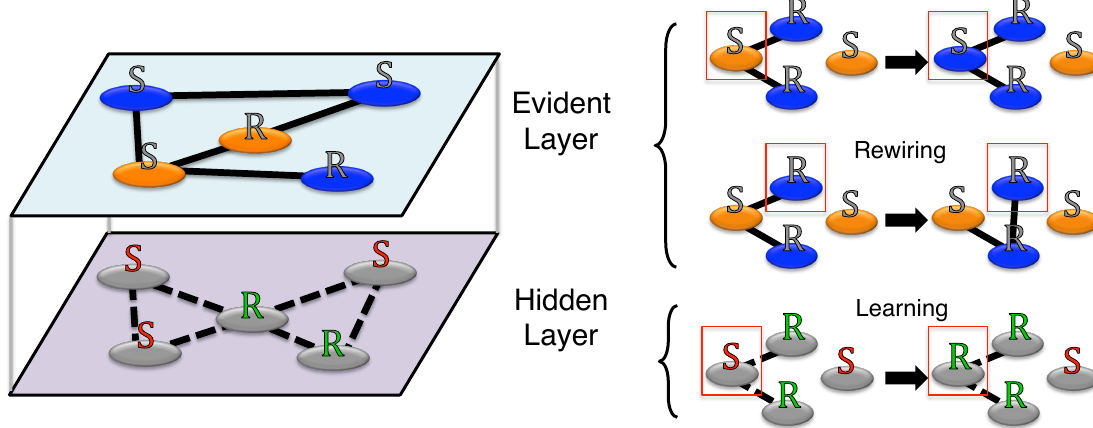
Figure 1. Visualization of the adaptive multiplex network model. The coordination with neighbor actions dynamics happens in the evident layer through imitation (according to S -agents) and rewiring (for R -agents), while the learning dynamics occurs in the hidden layer through payoff-driven strategy imitation. Actions are represented as node colors (orange and blue) while strategies are represented as node labels ( R for rewiring agents, S for staying ones). Imitation refers to the coordination game according to which agents update their actions on the evident layer. Rewiring indicates the possibility, on the evident layer, for an agent to cut a link with a neighbor of opposite action and then create a link with another randomly chosen agent. Learning denotes the propagation of strategies over the hidden